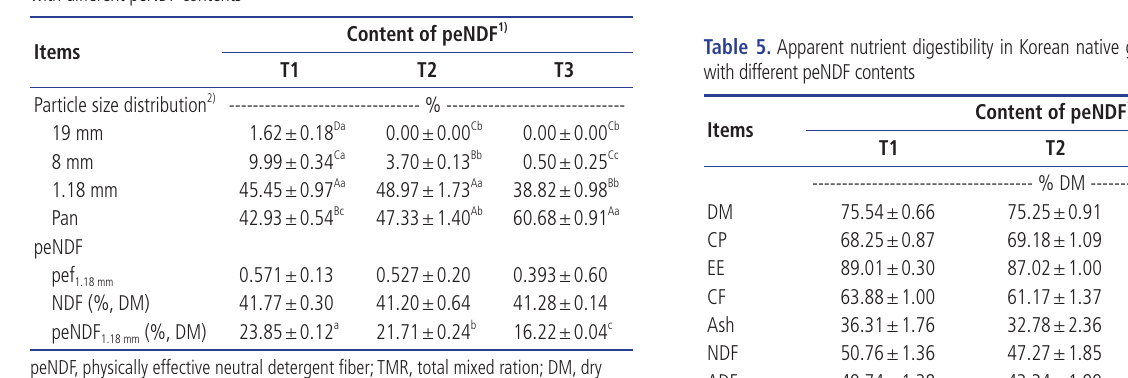
Table 3. Particle size distribution and peNDF content of the experimental TMR feeds with different peNDF contents